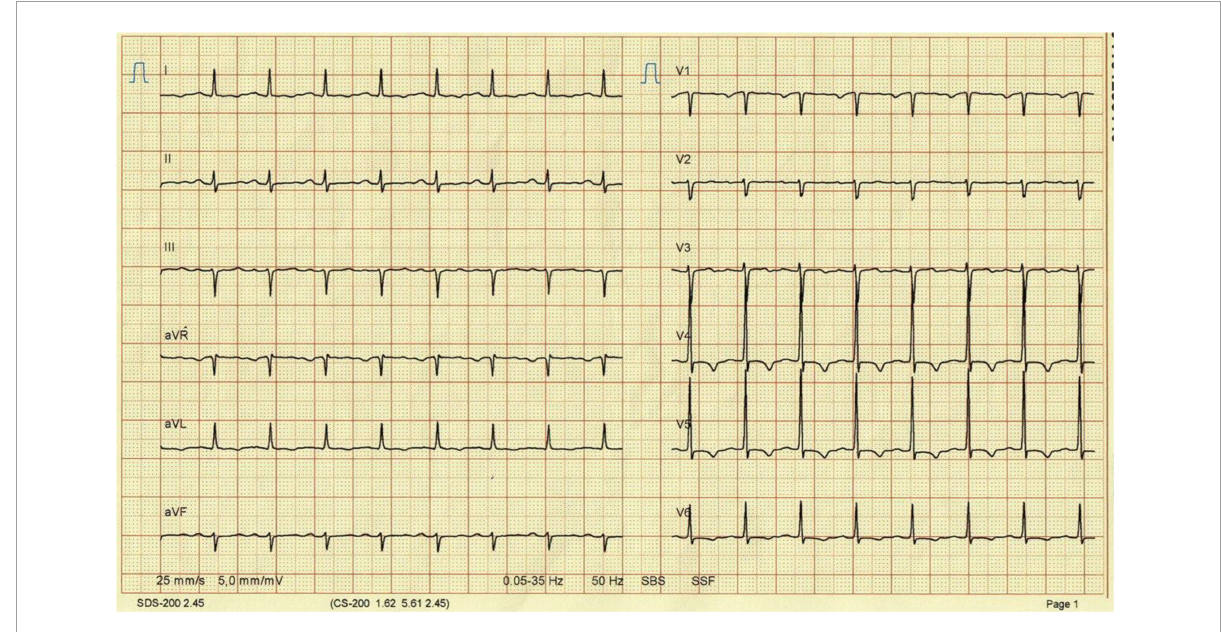
FIGURE1 Electrocardiography reveals an atrioventricular type 1.